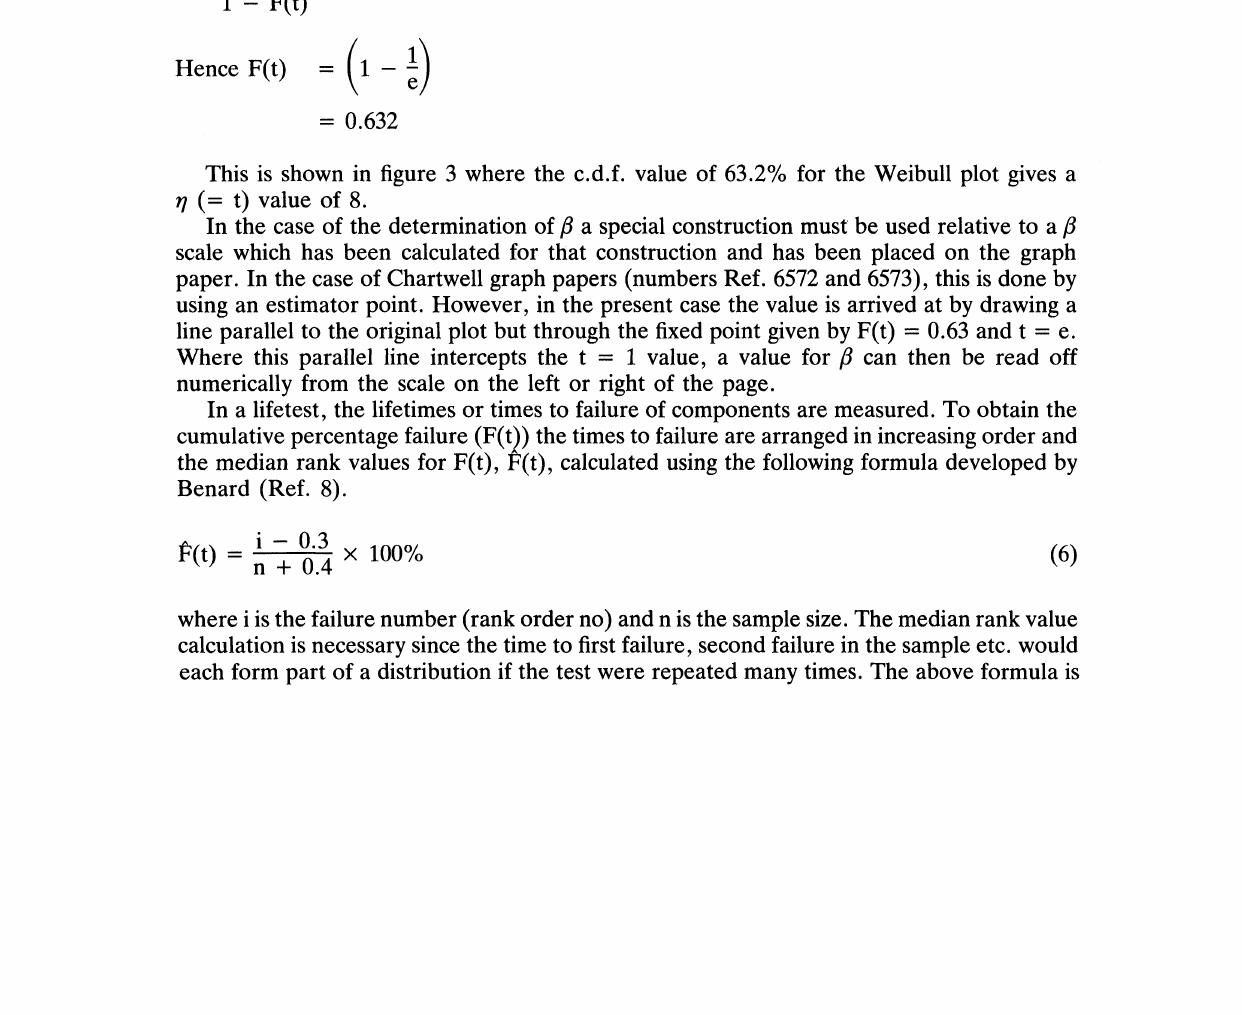
FIGURE 2 An example of a Weibull graph